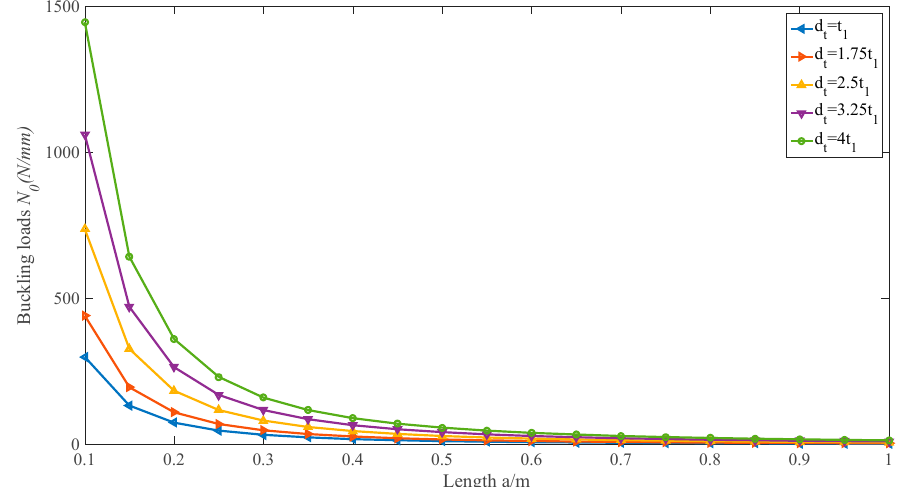
Figure 10. Buckling affected by honeycomb reinforcement’s thickness.